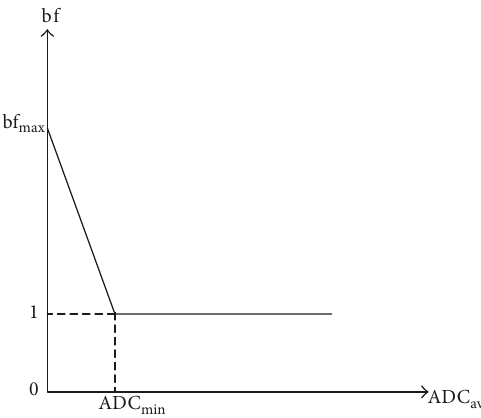
Figure 4: Function for updating the boost